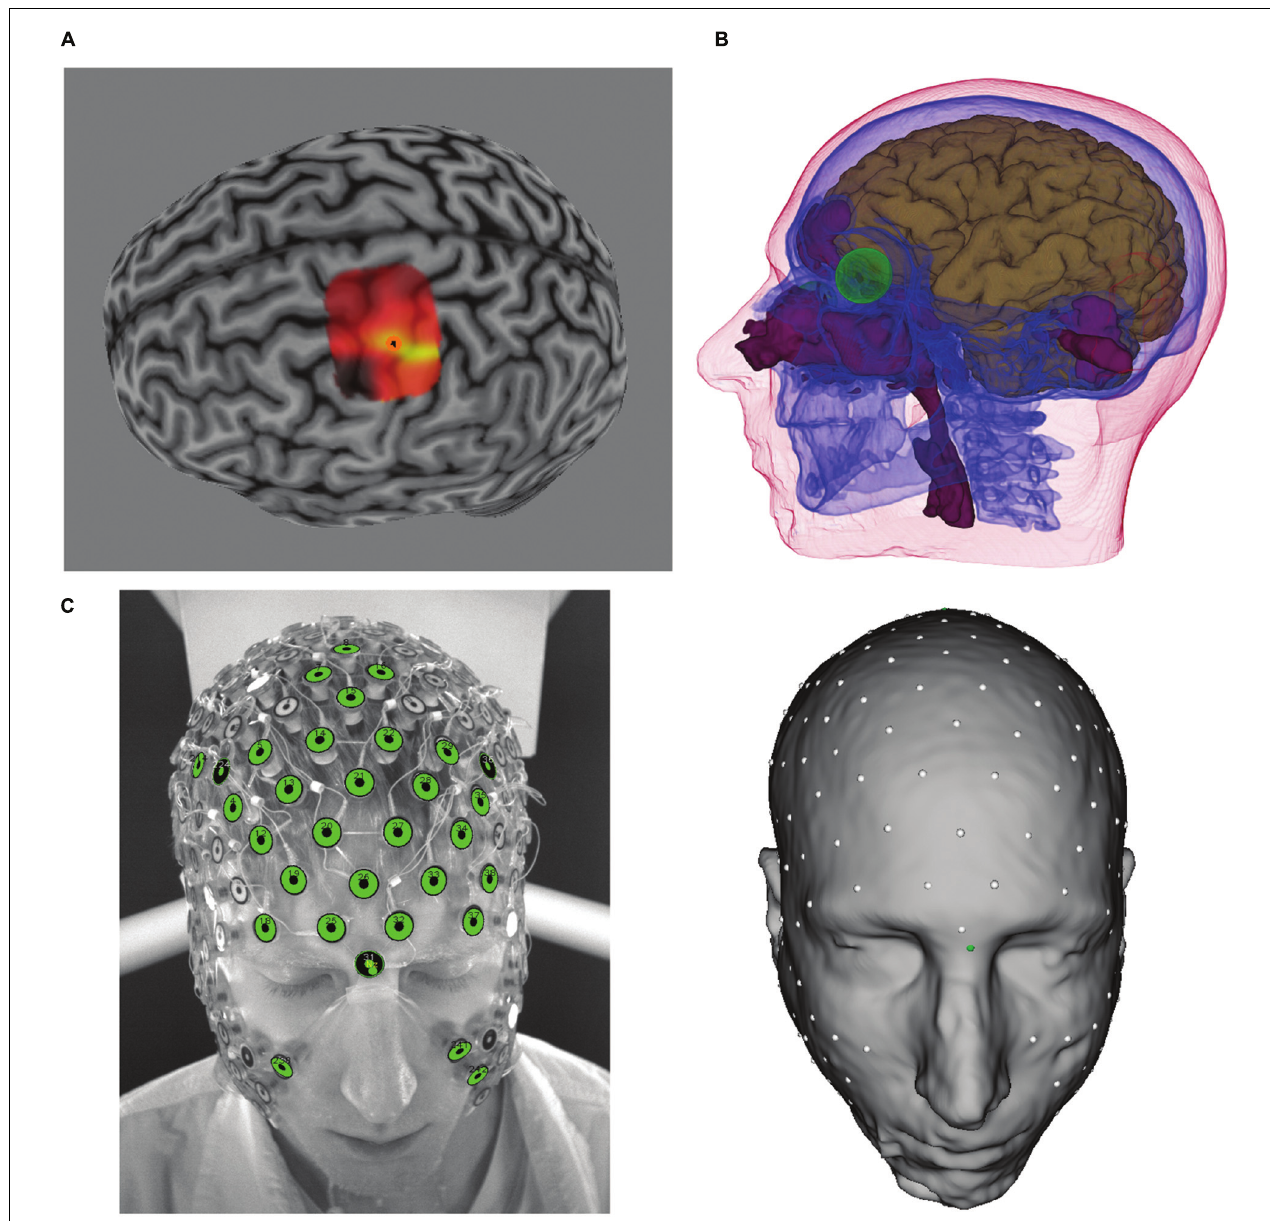
FIGURE 1 | (A) Transcranial magnetic stimulation (TMS)-induced motor evoked potentials (MEP) heat map over M1. Brighter colors represent larger MEP amplitudes. Orange circle denotes “hotspot.” (B) Tissues identified from MRI and atlas CT, including brain (brown), skull (blue), eyes (green), air (purple), and scalp. Not shown are white matter and CSF. (C) photographic image from GPS (left) and sensors registered to the scalp surface